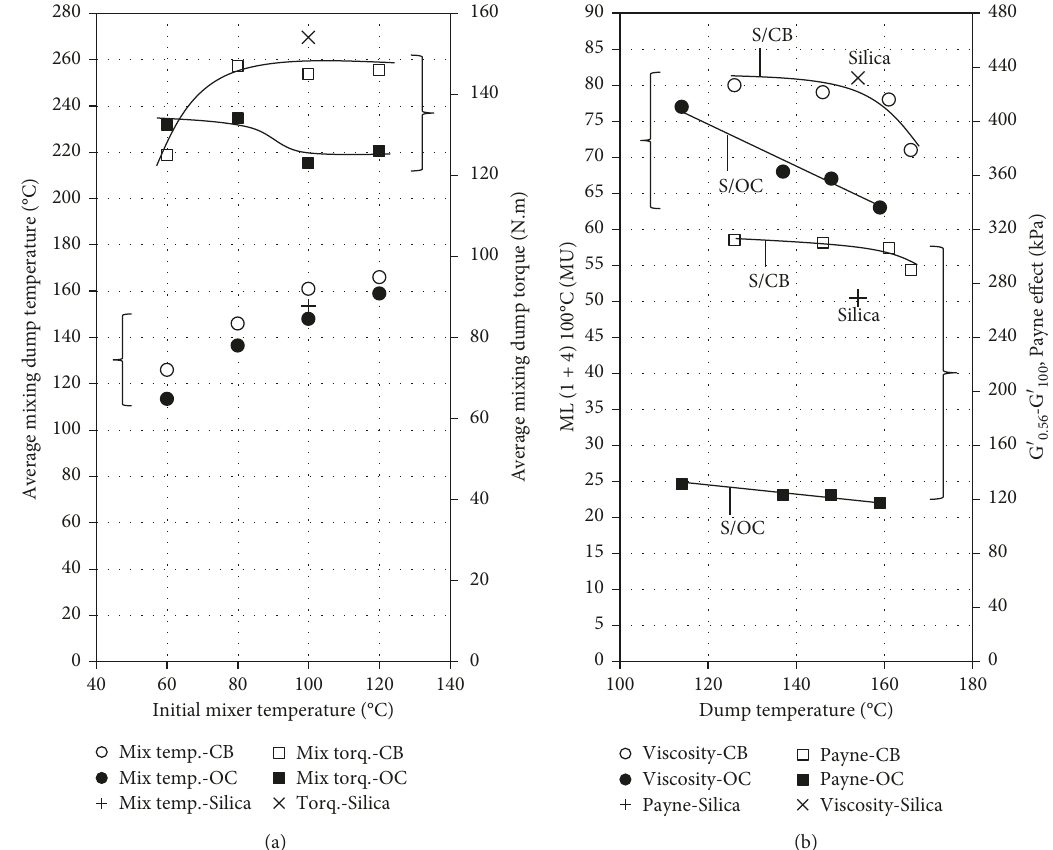
Figure 2: Average mixer dump/discharge temperature and torque at the final stage of mixing in the internal mixer as a function of initial mixer temperature setting (a) and influence of dump temperature on viscosity and Payne effect of silica- (S-) filled NR compounds with different secondary fillers (b).